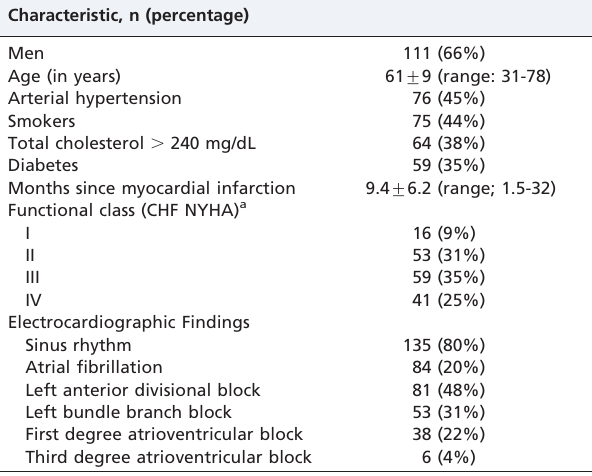
Table 1 - Baseline clinical characteristics of the study population (n = 169).